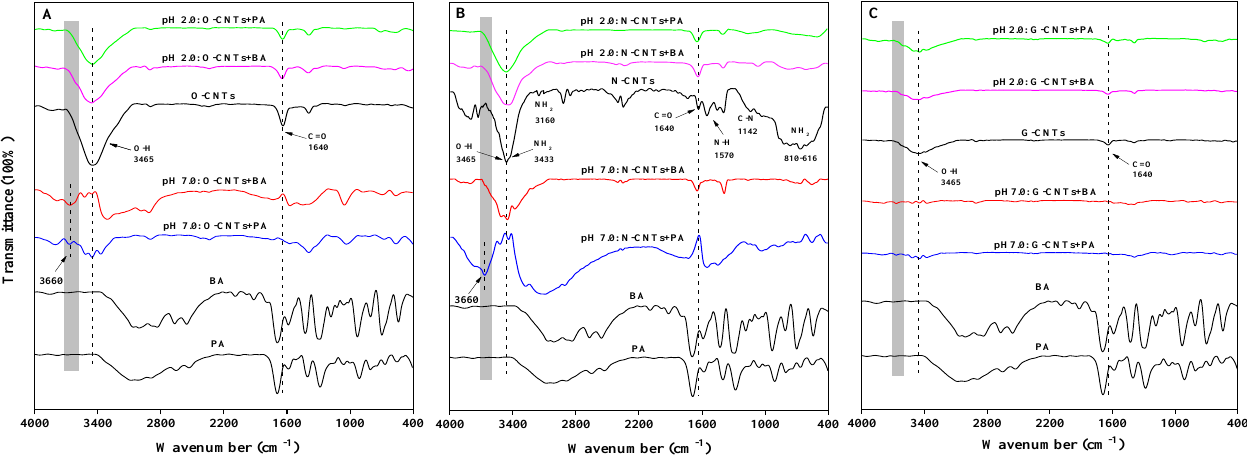
Figure 5. FTIR spectra analysis of before and after adsorption of BA and PA on the O-CNTs ( A ), N-CNTs ( B ) and G-CNTs ( C ) at pH 2.0 and 7.0, respectively. A clearly new peak appeared at the higher frequency (3660 cm − 1 , the blue shift of O − H or –NH 2 ) reveals the formation of the homonuclear CAHB or heteronuclear CAHB.